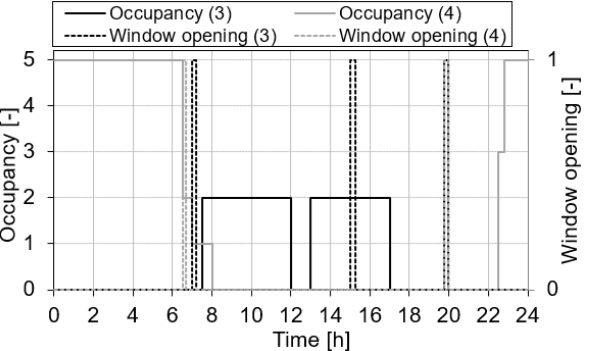
Figure 7. Occupancy and ventilation profile of the office room (3) and the bedroom